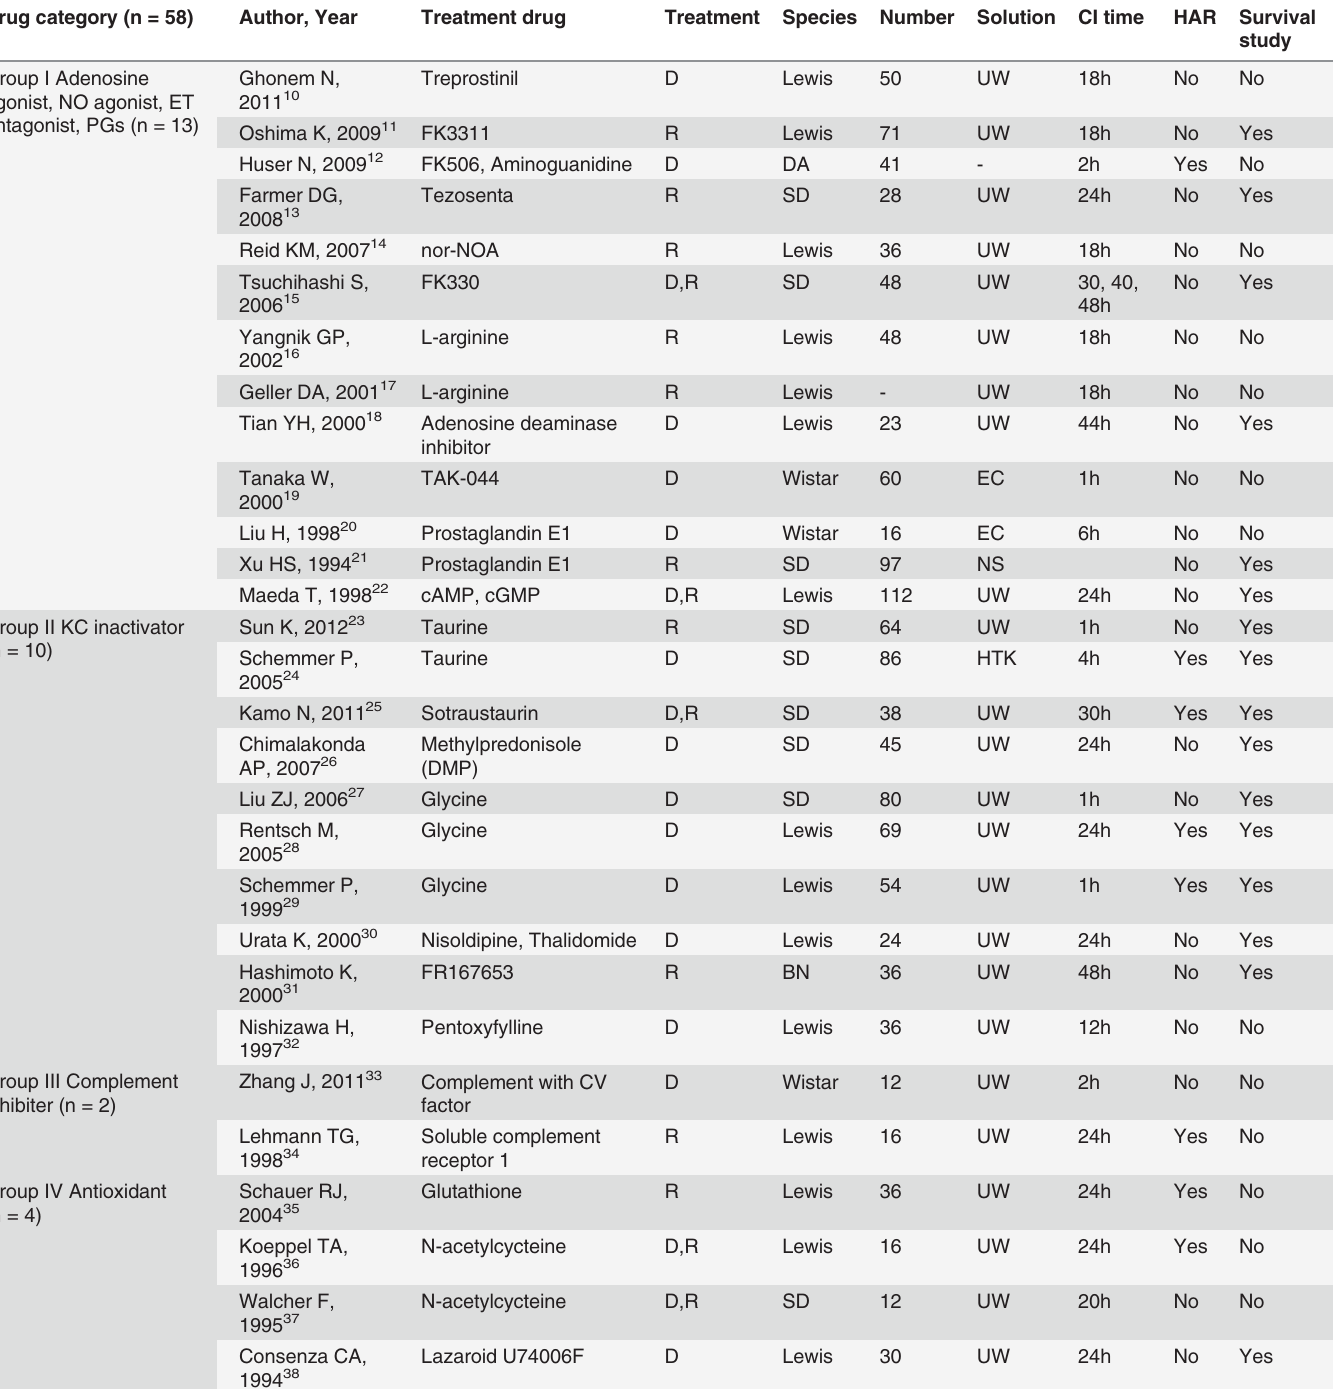
Table 1. Characteristics of experimental studies included in the systematic